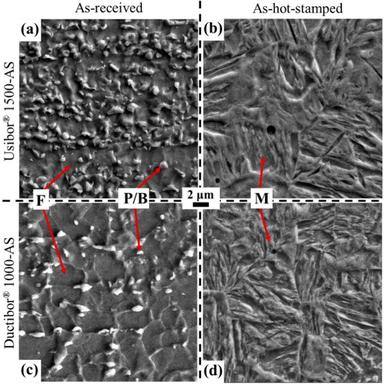
Scanning electron micro-images of as-received and hot stamped conditions for (a) and (b) of Usibor® 1500-AS, and (c) and (d) Ductibor® 1000-AS. P: Pearlite, B: Bainite, F: Ferrite, M: Martensite.